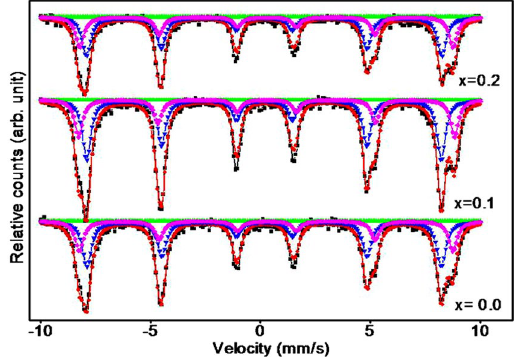
Figure 5. Mossbauer spectra of CBF for x = 0.0, 0.1 and 0.2.